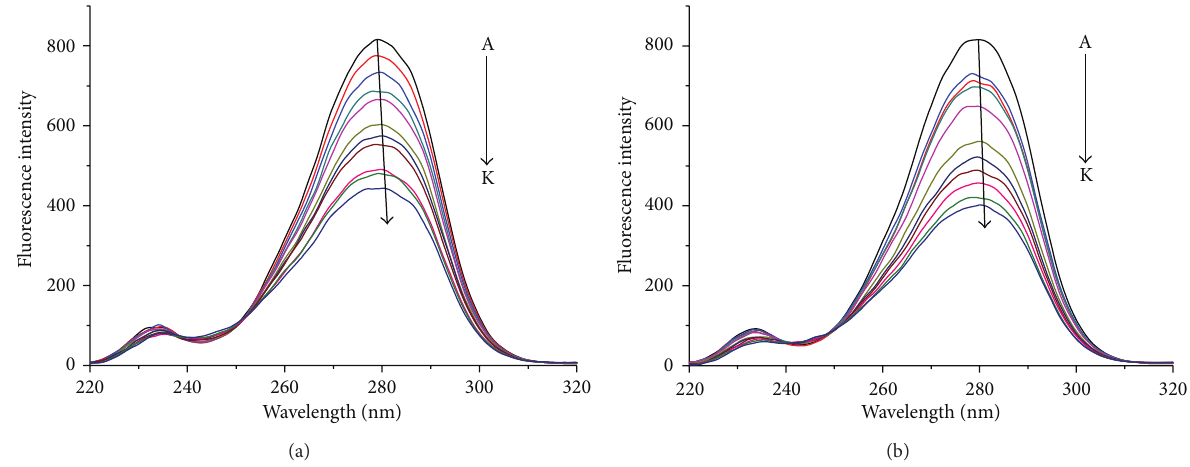
Figure 6: Synchronous fluorescence spectrum of BSA in the presence of CA (a) and LB (b) (𝑇 = 310 K , Δ𝜆 = 60 nm , pH = 7.40) . C(BSA) = 2 × 10 −6 molL −1 ; C(CA)/( 10 −6 mol L −1 ), A–K: 0, 0.8, 2.5, 3.5,5.0, 8.0, 10.0, 12.0, 14.0, 16.0, 18.0.